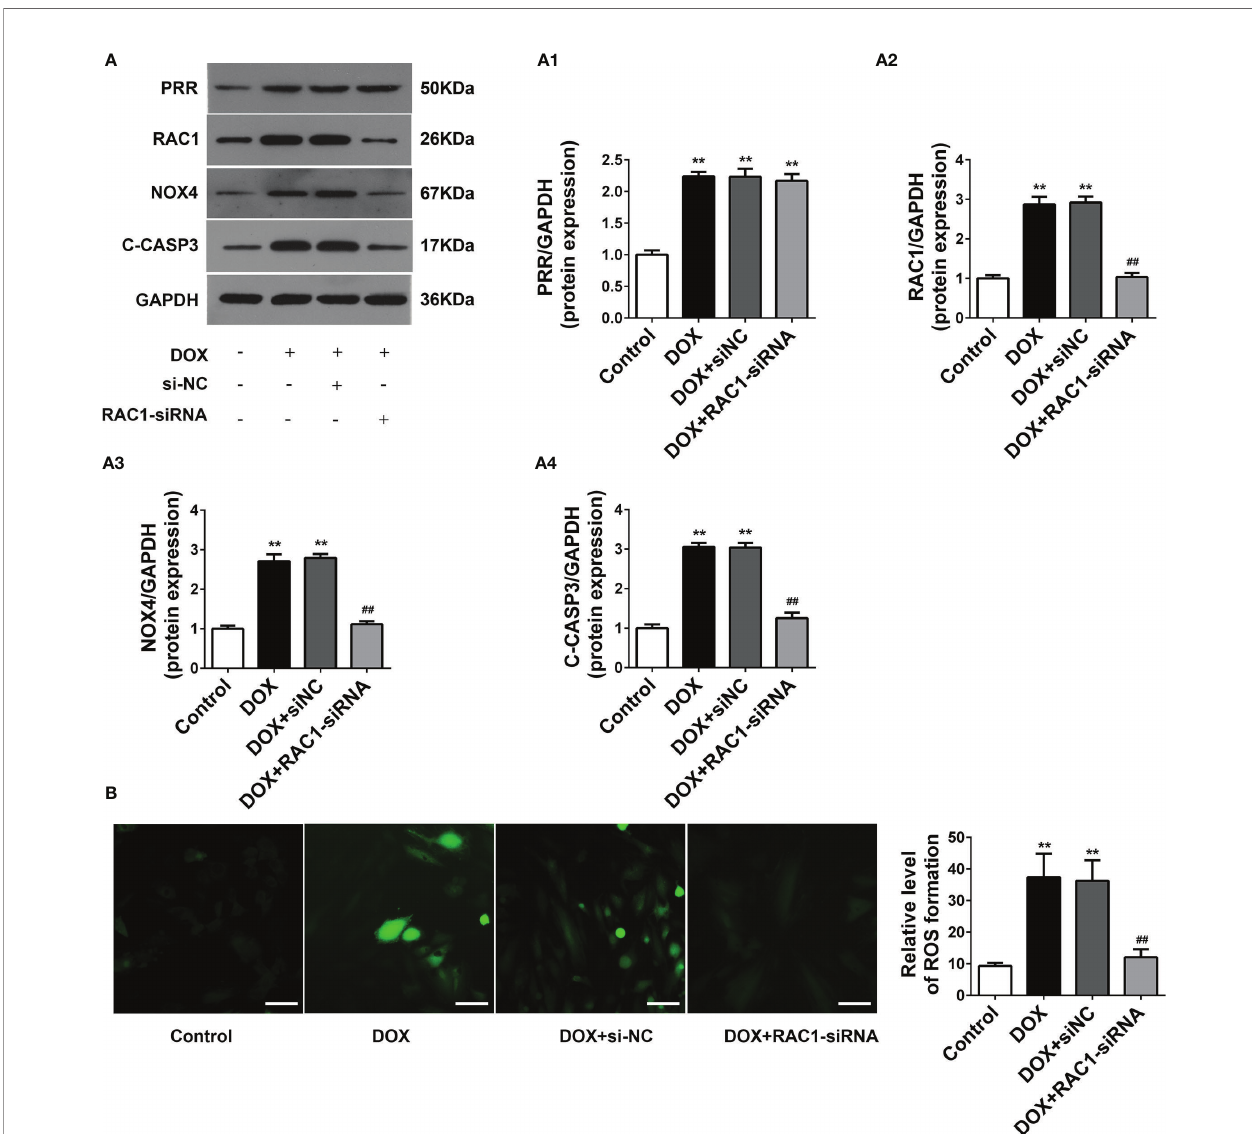
FIGURE 4 | The effect of RAC1 inhibition on the regulation of ROS-related protein levels in doxorubicin (DOX)-treated H9C2 cells. (A) Protein expressions of PRR, RAC1, NOX4 and cleaved Caspase3 after RAC1 inhibition in H9C2 cells. (A1)-(A4) Quanti fi cation of PRR/GAPDH, RAC1/GAPDH, and NOX4/GAPDH levels with a change in RAC1 expression. (B) Representative oxidative stress levels as determined by the DCFH-DA assay. (** p < 0.01 vs the control group. ## p < 0.01 vs DOX